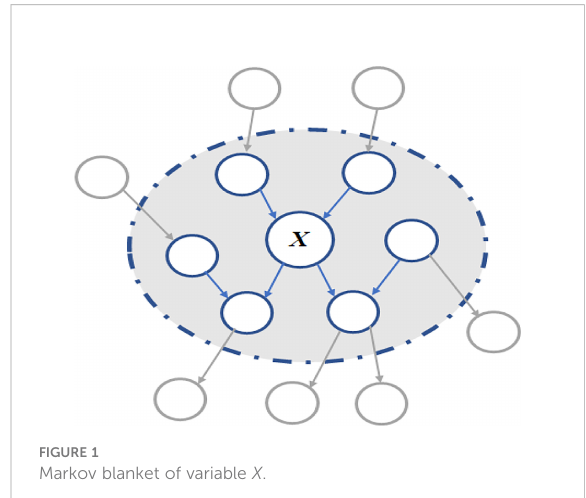
FIGURE 1 Markov blanket of variable X